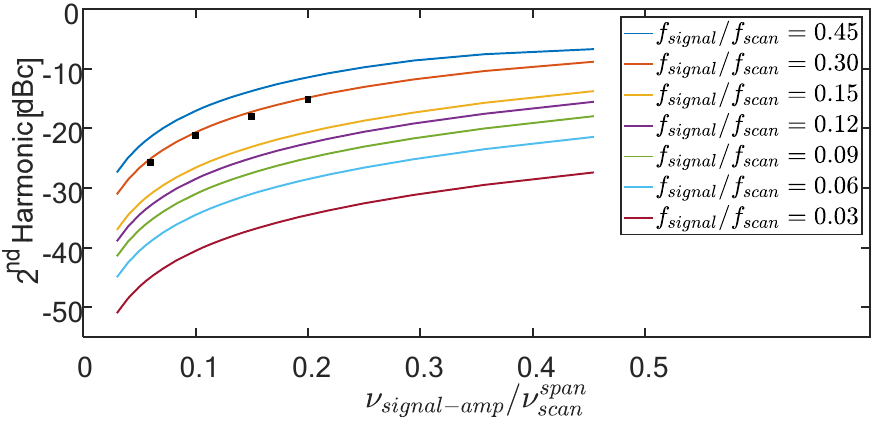
Figure 4. The power (magnitude-squared value) of the second harmonic of an originally pure sinusoidal signal, when acquired from its temporally non-uniform per-period intersections with the linear (instantaneous fly back) saw-tooth scanning waveform of Figure 1. Simulated results are shown for a range of scaled signal frequencies ( 𝜉 -legends box) and filling factors ( 𝜂 -abscissa). The higher 𝜉 and/or 𝜂 , the worse the harmonic distortion. The corresponding total harmonic distortion curves lie within half a dB from the displayed second harmonic ones. The black squares represent experimental results for the Brillouin setup of Section 4. Note that a different scan pattern, such as a triangular one, will result in different curves.